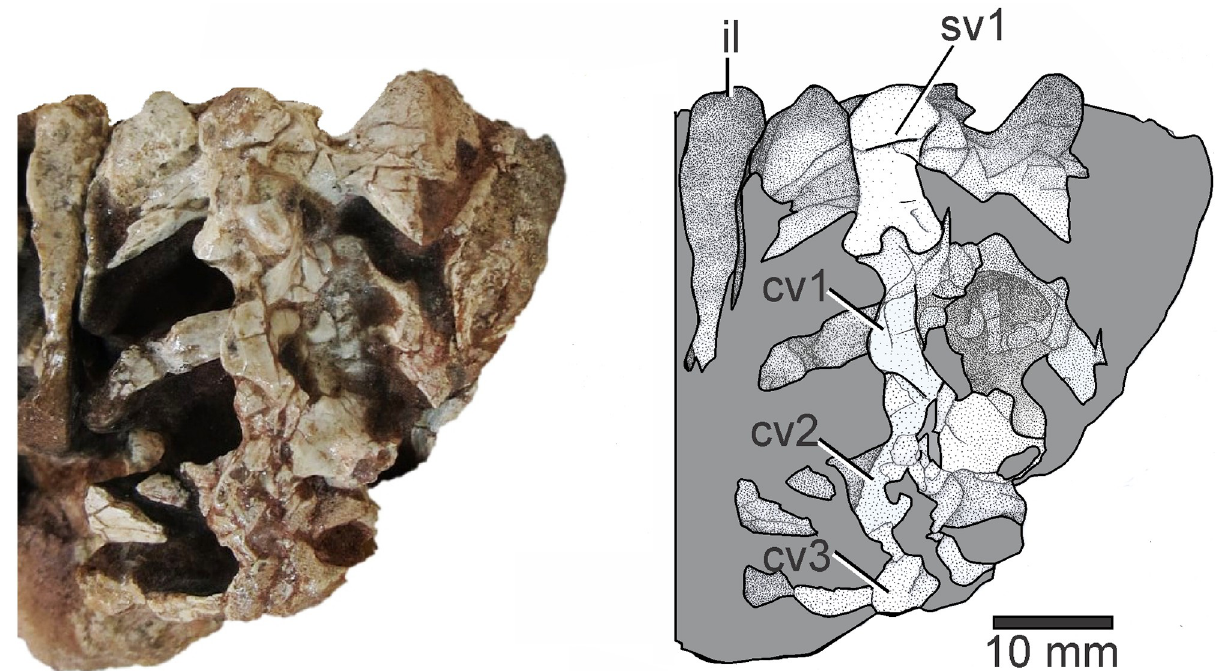
Fig 4. Sacral and caudal vertebrae of Elessaurus gondwanoccidens (UFSM 11471) in dorsal view. Photograph and explanatory drawing respectively. Abbreviations: sv2, second sacral vertebra; cv, caudal vertebrae 1–3.